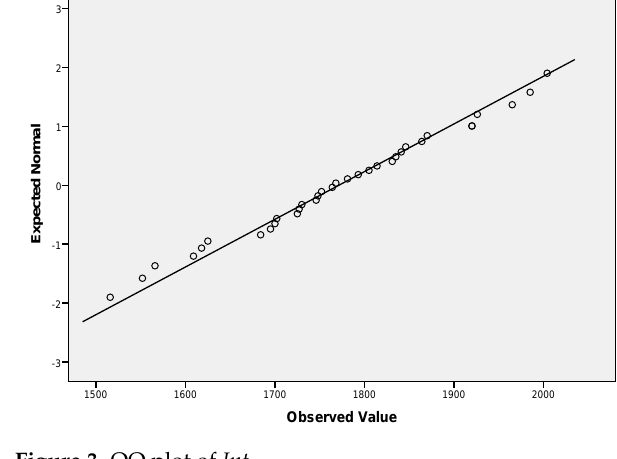
Figure 3. QQ plot of Int 1 ∗ .